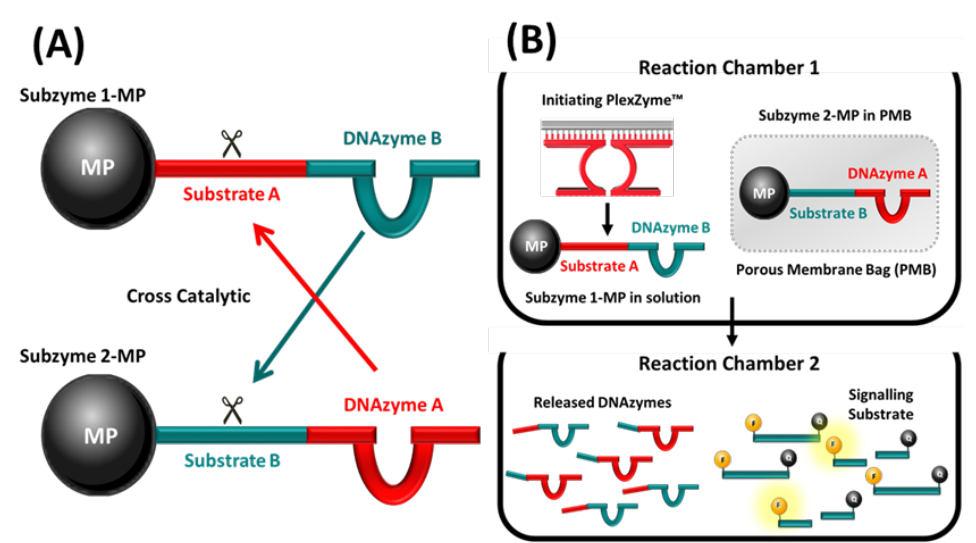
Figure 1. ( A ) Schema illustrating the concept of Subzyme pairs capable of cross-catalysis. Subzymes are depicted attached to microparticles (MP). Subzyme 1-MP comprises DNAzyme B linked to Substrate A which is cleavable by DNAzyme A of Subzyme 2-MP. Subzyme 2-MP comprises DNAzyme A linked to Substrate B which is cleavable by DNAzyme B of Subzyme 1-MP. ( B ) A cross-catalytic feedback cascade in which PMBs and Subzyme-MPs are used to amplify signal following detection of a DNA target. Reactions contain Subzyme 1-MP, Subzyme 2-MP inside a PMB and partzymes for the chosen DNA target. In the presence of the target, the partzymes align and form an initiating PlexZyme which cleaves Substrate A within Subzyme 1-MP separating DNAzyme B from the MP. This allows DNAzyme B to migrate through the PMB, where it can cleave Substrate B within Subzyme 2-MP, thus separating DNAzyme A from the MP. DNAzyme A is now free to migrate from the PMB into solution, where it can cleave Substrate A within Subzyme 1-MP and initiate the cascade. After a period of incubation, the supernatant containing the free DNAzymes can be transferred to another reaction chamber containing the signaling substrate. The fluorescence which is generated following the separation of the fluorophore (F) and the quencher (Q) by DNAzyme cleavage can be measured to indicate the presence or absence of target DNA.